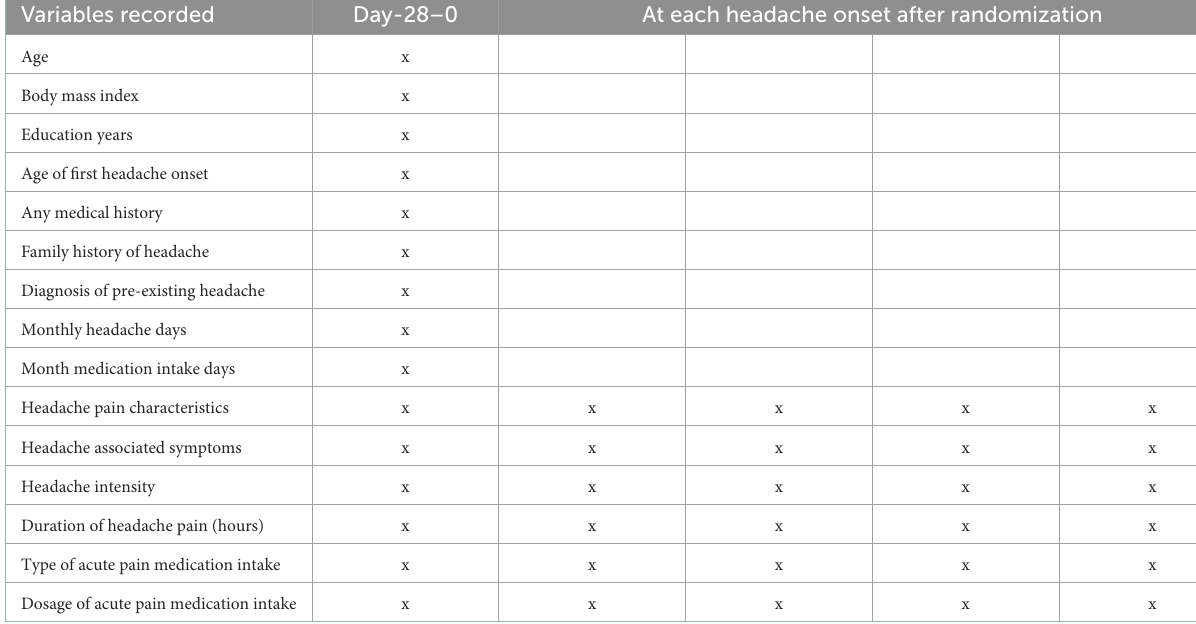
TABLE 3 Summary of data collection from eDiary. Variables recorded Day-28–0 At each headache onset after